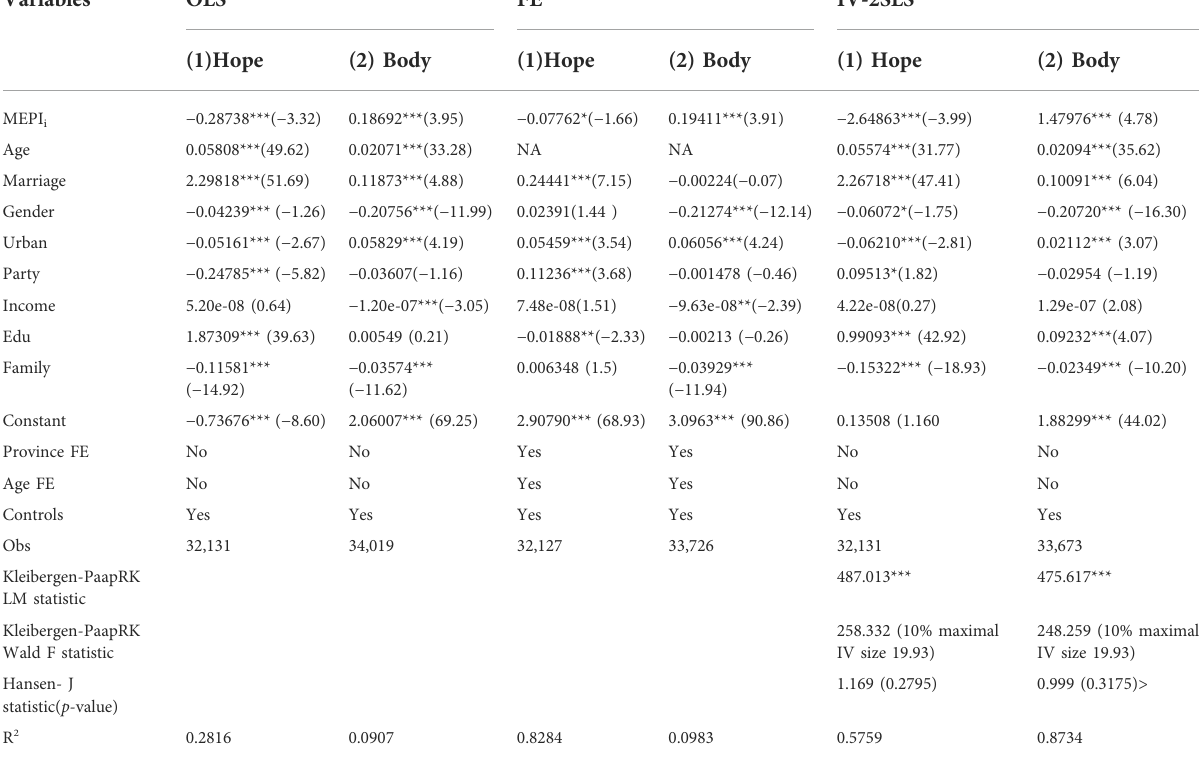
TABLE 4 Benchmark regression